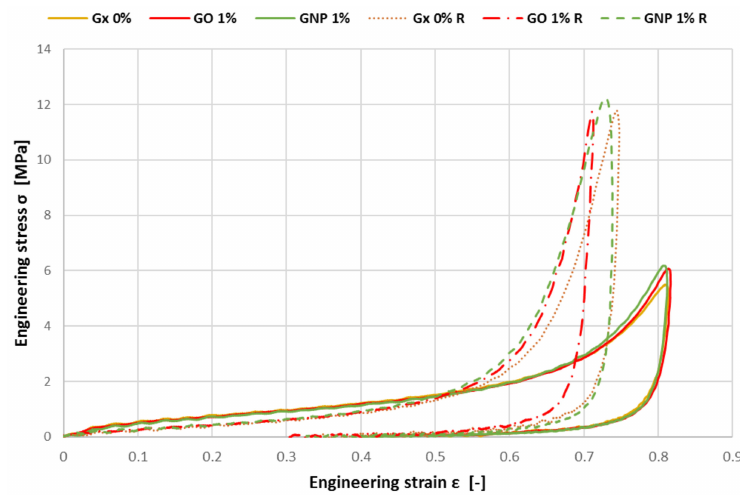
Figure 8. Stress-strain curves for the specimens during the first impact and second impact (marked by R).